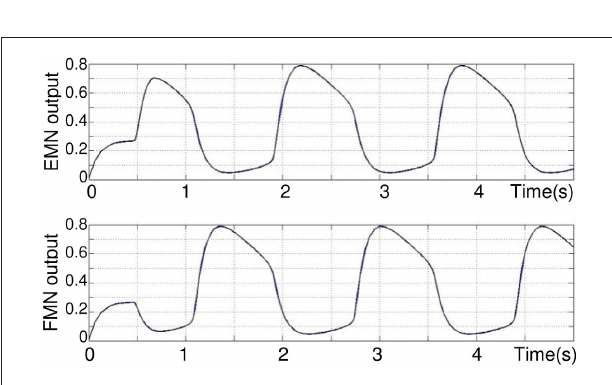
FiguRe 6 | Oscillations in Rowat–Selverston-type neurons implemented in extensor and flexor joint controllers, respectively. The output is normalized. τ = 0.05 s, τ = 1 s, τ = 0.05 s, m s m = σ = 3, A = σ f s f